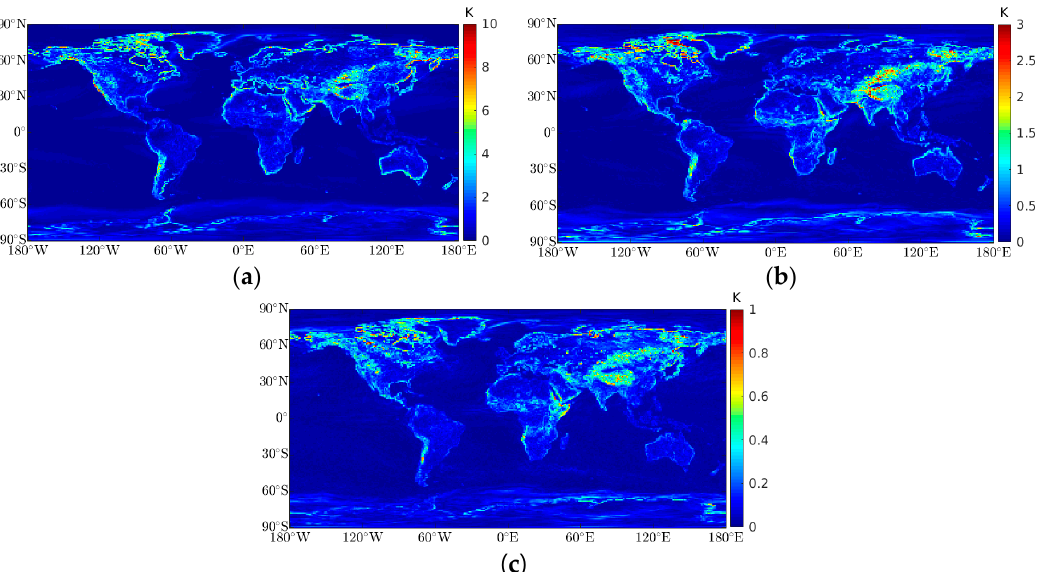
Figure 2. Maximum spatial variability for each surface air temperature periodicity, which was calculated using a window of 4 × 4 grid points, approximately a 1° × 1° horizontal grid: ( a ) maximum spatial variability for the annual amplitude (K), ( b ) maximum spatial variability for the semi-annual amplitude (K), and ( c ) maximum spatial variability for the quarterly amplitude (K).